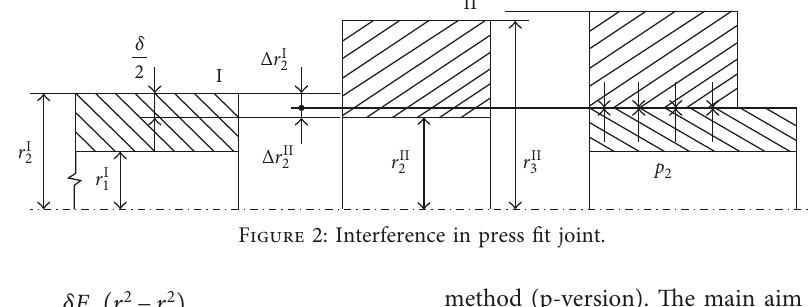
Figure 2: Interference in press fit